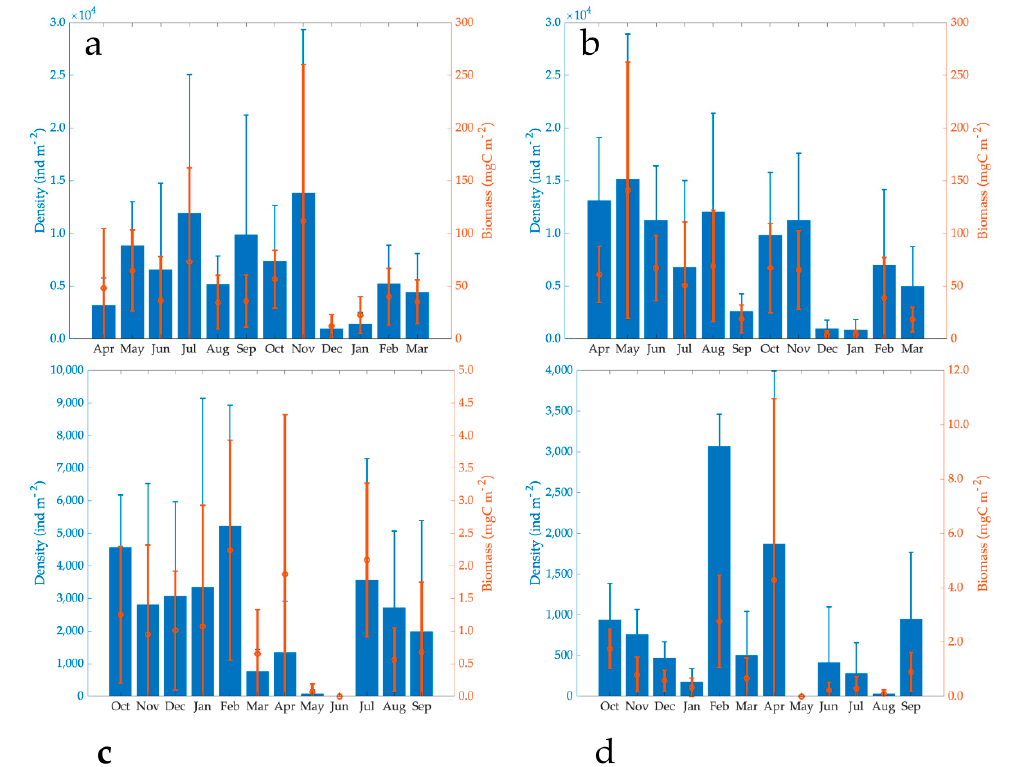
Figure 4. Temporal dynamics of the BMI density and biomass (average ± standard deviation) in Lake El Sol (( a ): 2000–2001,